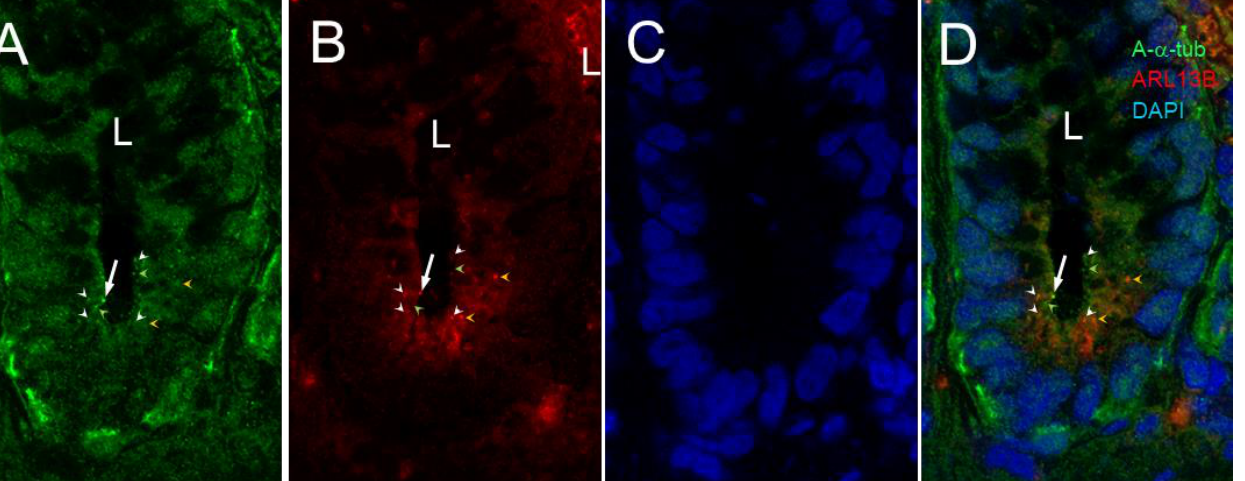
Figure 1. Primary cilia in the human small intestine. ( A ) Schematic of the crypt–villus axis showing the crypt region depicted in B and C. ( B ) Representative immunodetection of primary cilia using anti-acetylated- α -tubulin (A- α -tub; arrow, green staining) in the epithelial cells (E-cadherin, E-cad; red staining) of a crypt in the human adult small intestine (L, lumen). Nuclei were stained with DAPI (blue staining). Smaller structures that could be related to either midbody remnants [64] or centrosomes (see below) were also detected (arrowheads). ( C ) 3D reconstruction of double immunostaining of anti- α -acetylated-tubulin (green), showing primary cilia (arrow) and smaller structures (arrowheads) as well as anti-phospholipase A2 (red), a Paneth cell marker (L, lumen; P, Paneth cell). Nuclei were stained with DAPI (blue) and are out of focus because they are present on a lower plane of focus. Scale bars are equal to 10 µ m. ( B’ ) Higher magnification of the primary cilium seen in B (arrow).